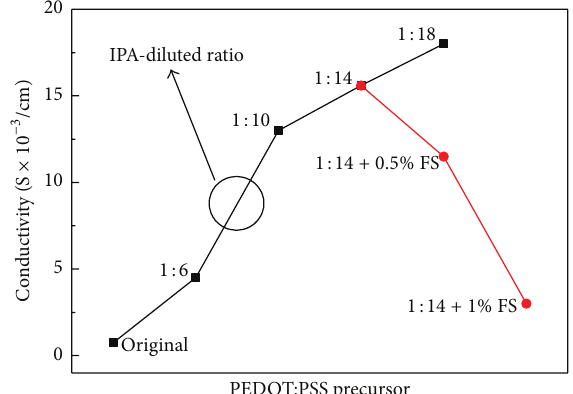
Figure 3: Conductivities of PEDOT:PSS films which are made up of different